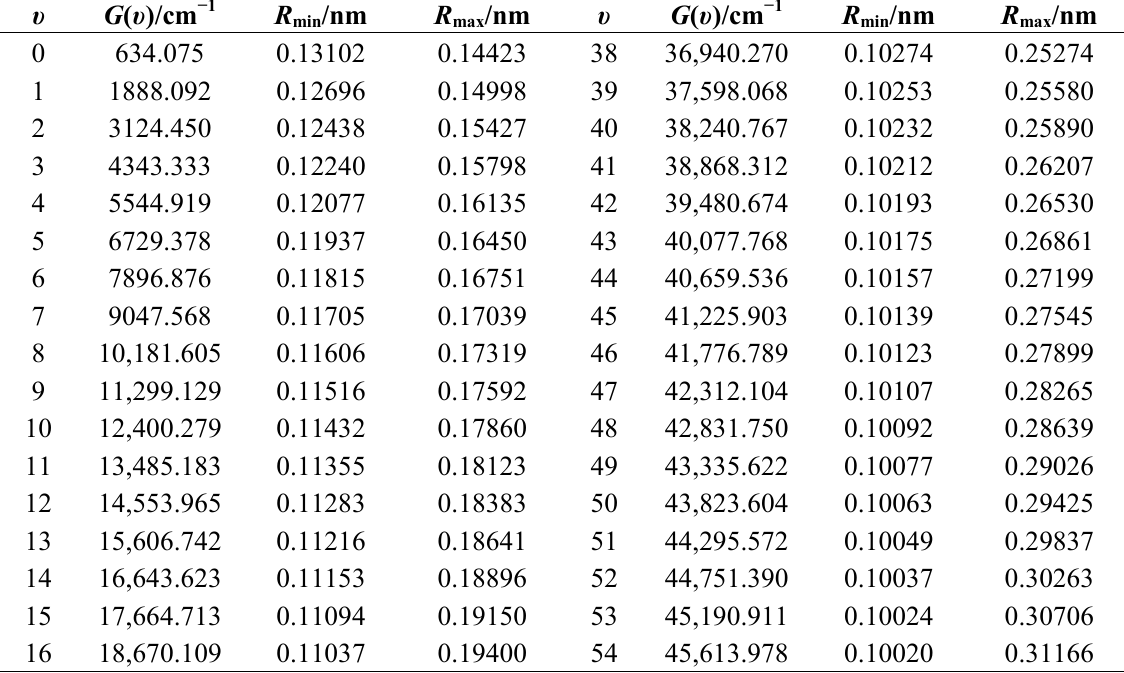
Table 3. Vibrational levels and classical turning points for BeF(X 2 Σ + ) radical when J = 0 at the MRCI level of